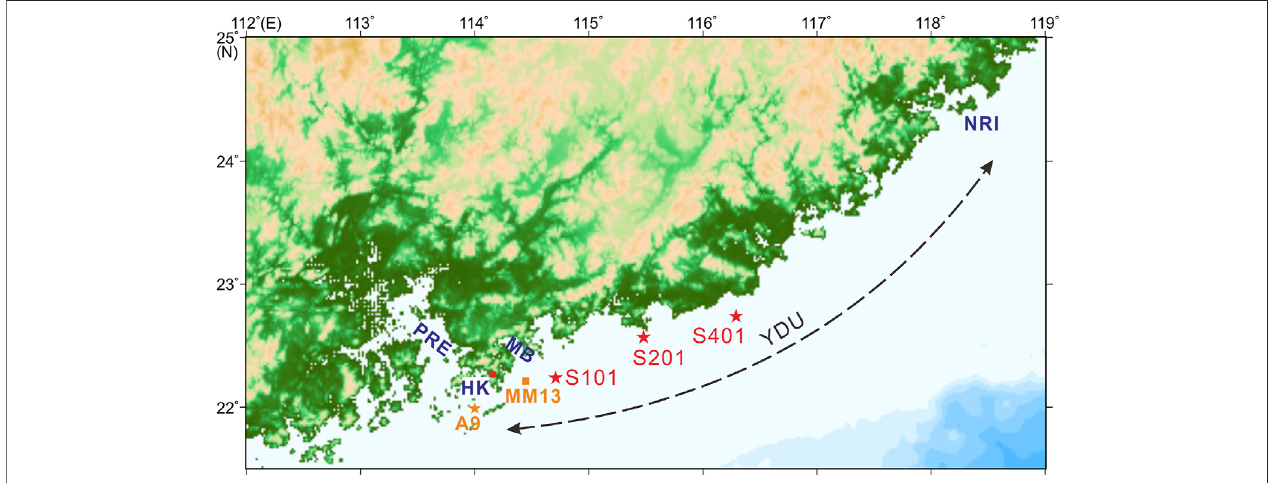
FIGURE1| Location oftheYDU,sedimentcores(S101, S201,andS401:thisstudy; A9:Jiaetal.,2013andXuet al.,2020)andmonitoringstation(MM13:Zhang et al., 2018) mentioned in this study. PRE: Pearl River estuary; MB: Mirs Bay; HK: Hong Kong; NRI: Nanri Islands.